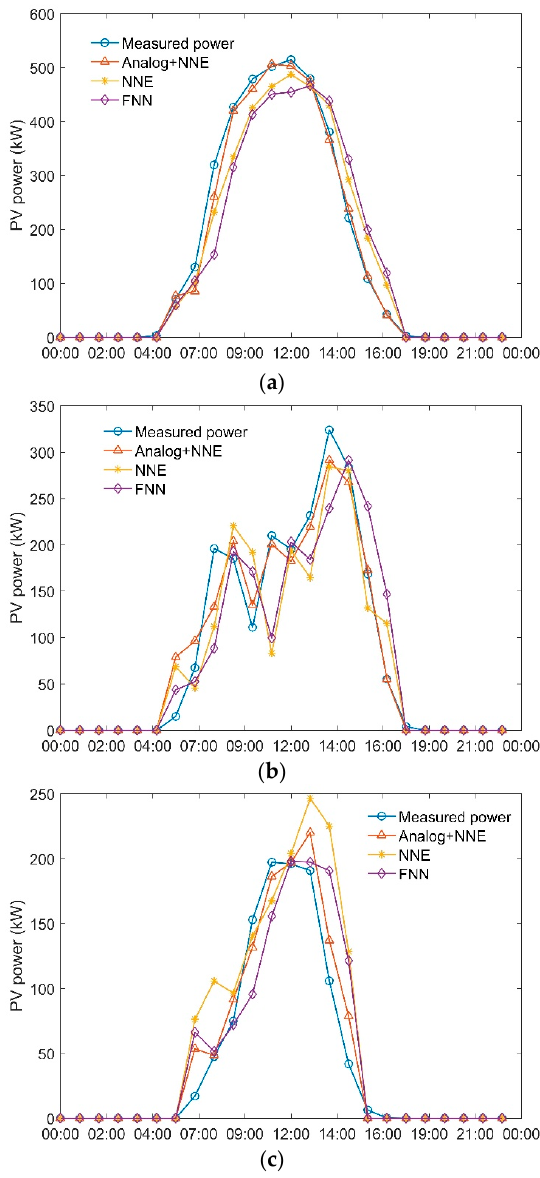
Figure 10. Examples of forecast results at different weather conditions: ( a ) clear day (daily K T = 0.65); ( b ) partially cloudy day (daily K T = 0.44); ( c ) cloudy day (daily K T = 0.21).